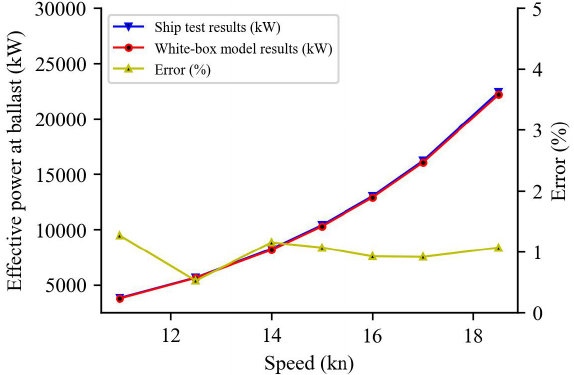
Figure 12. Still water resistance effective power at ballast.